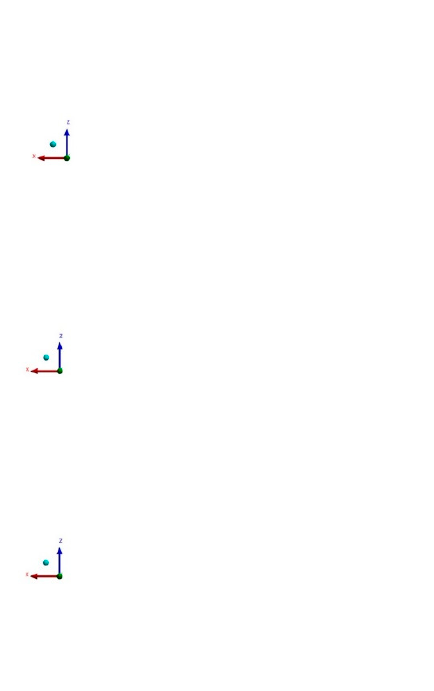
Figure 3. Sagittal view of the maximum principal stress maps (MPa) in the cement layer for each